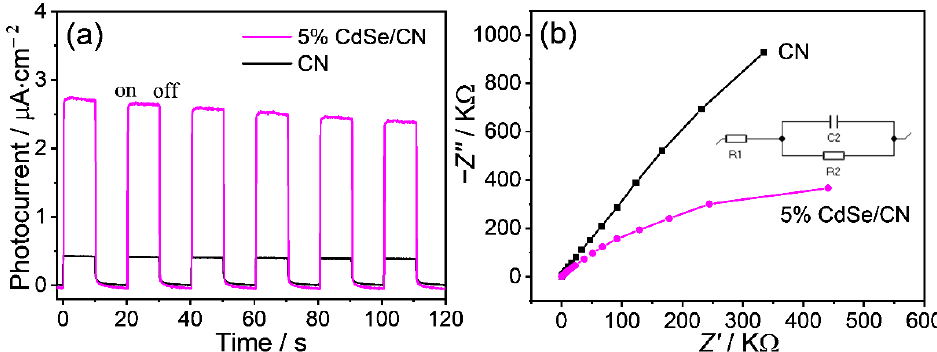
Figure 8. ( a ) Periodic on–off photocurrent response and ( b ) EIS Nyquist plots for 5% CdSe/CN com- posites and CN nanorods provided by drawing Z′ versus - Z″. Z′ and Z″ are defined by the real and imaginary part of impedance, respectively.